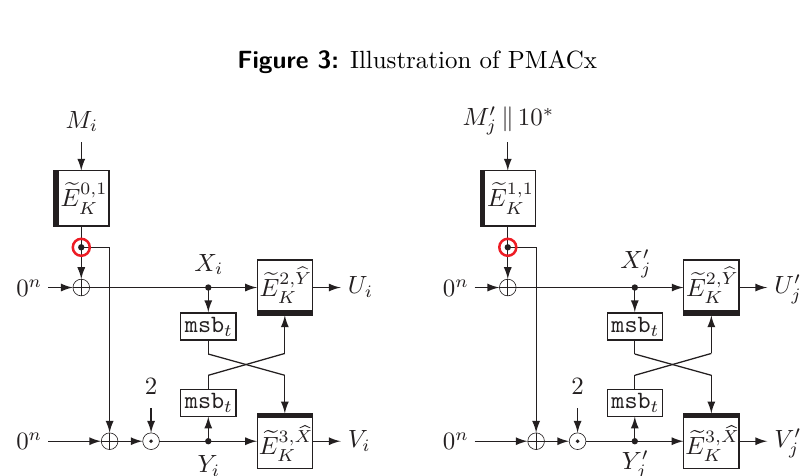
Figure 3: Illustration of PMACx